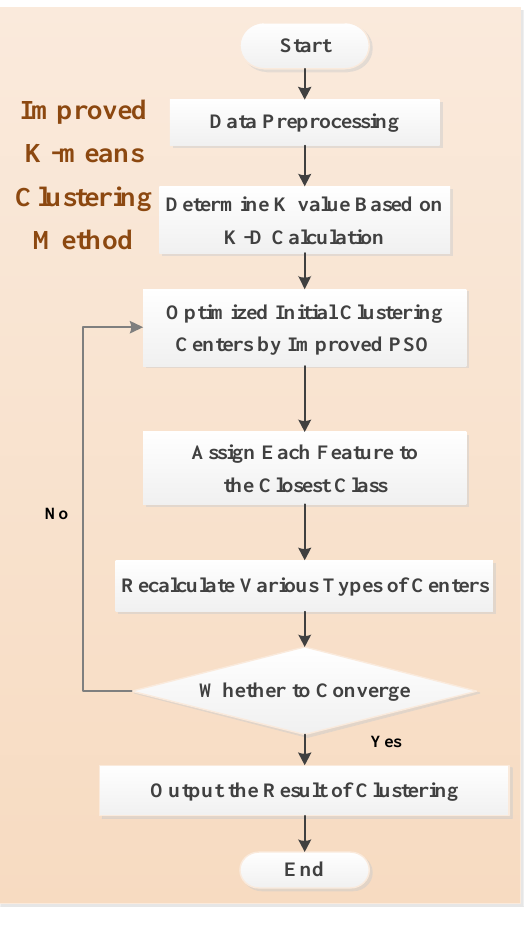
Figure 2. Improved k-means clustering algorithm.